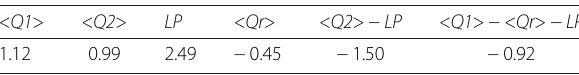
Table 1 The vertically integrated, EASP-averaged values for terms in Eqs. (3) to